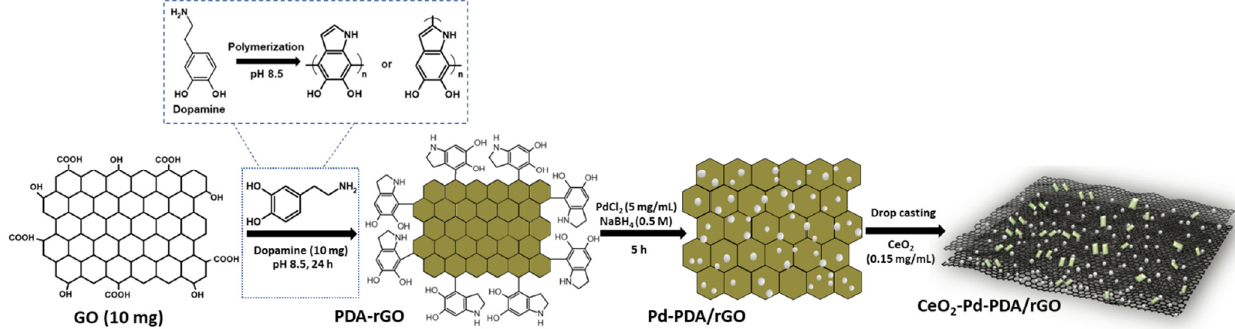
Figure 1. Schematic illustration of the synthesis process of the CeO 2 -Pd-PDA/rGO heterojunction nanocomposite.